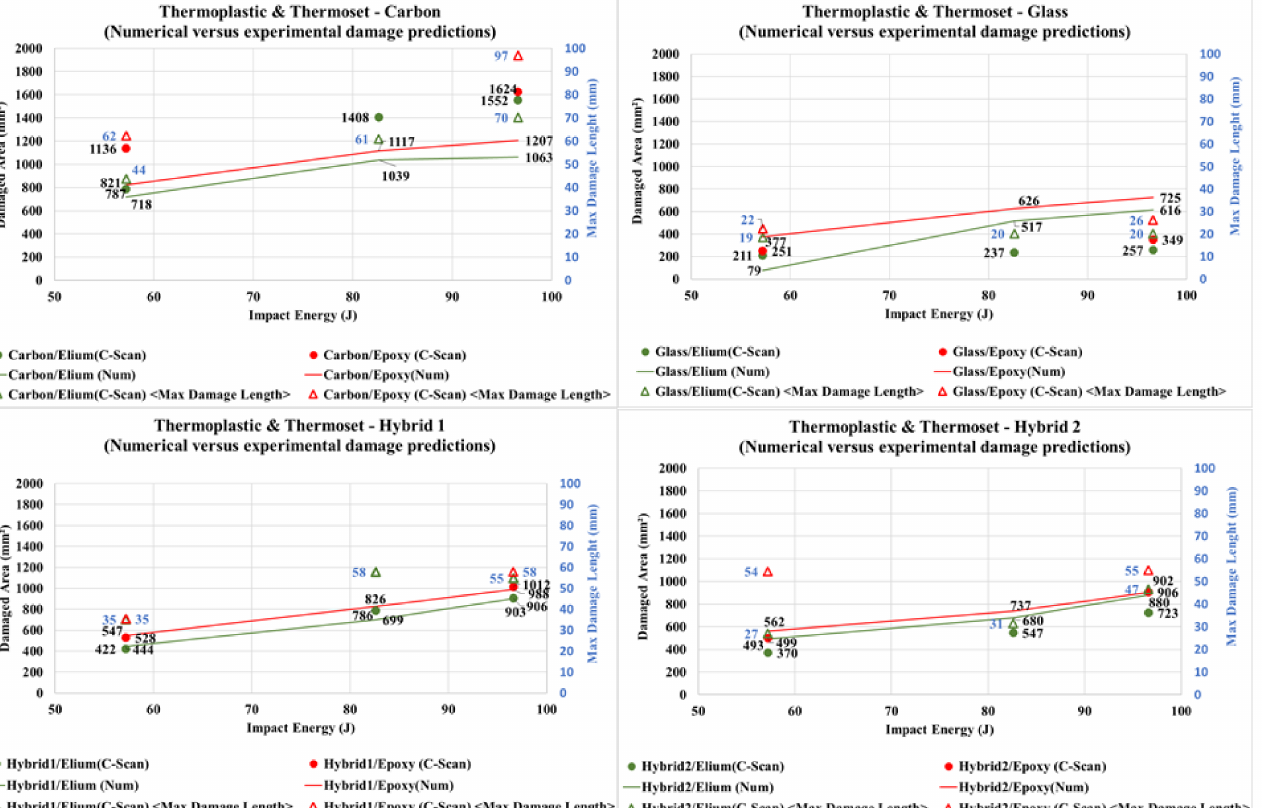
Figure 22. Numerical versus experimental damage